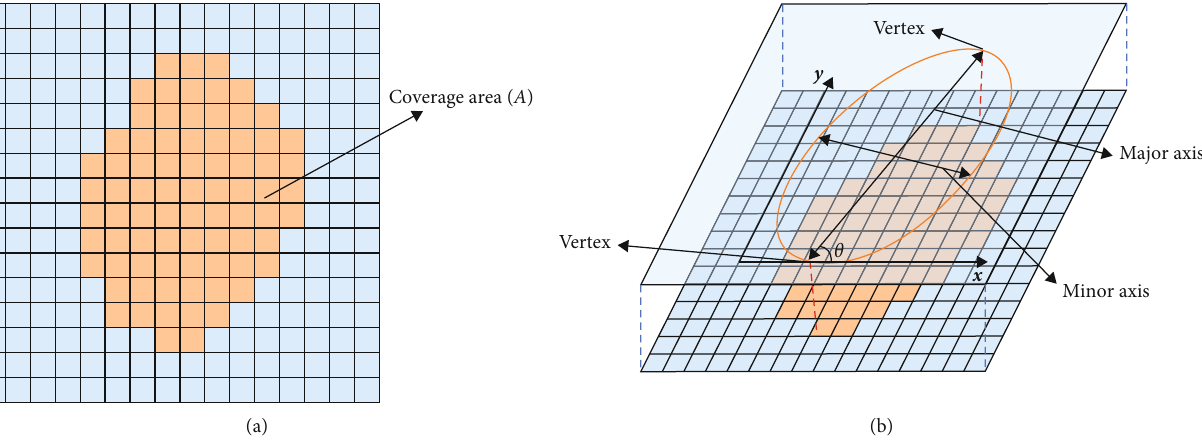
Figure 4: SEM image processing and particle identi fi cation. (a) Original image. (b) Binary image. (c) Erosion operation is used to eliminate narrow bridges and particles. (d) Pixels of the eroded part are integrated into the nearest connected regions. (e) Separated particles through the watershed algorithm. (f) Particles replaced by fi tting ellipses.